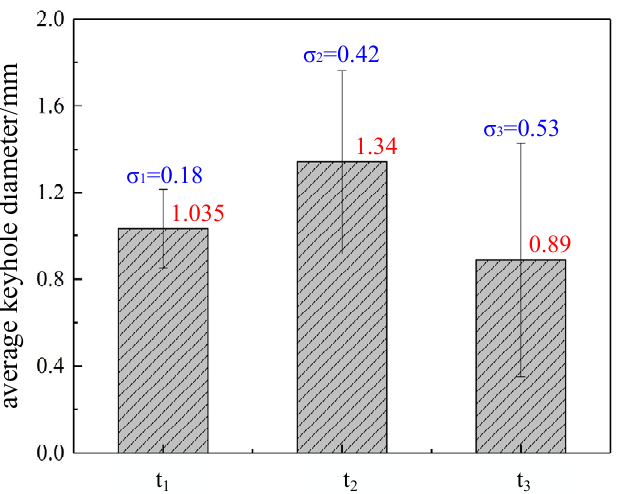
Figure 6. Average keyhole diameter and standard deviation during different stages. During the droplet growth stage, the average diameter of the keyhole is 1.035 mm,